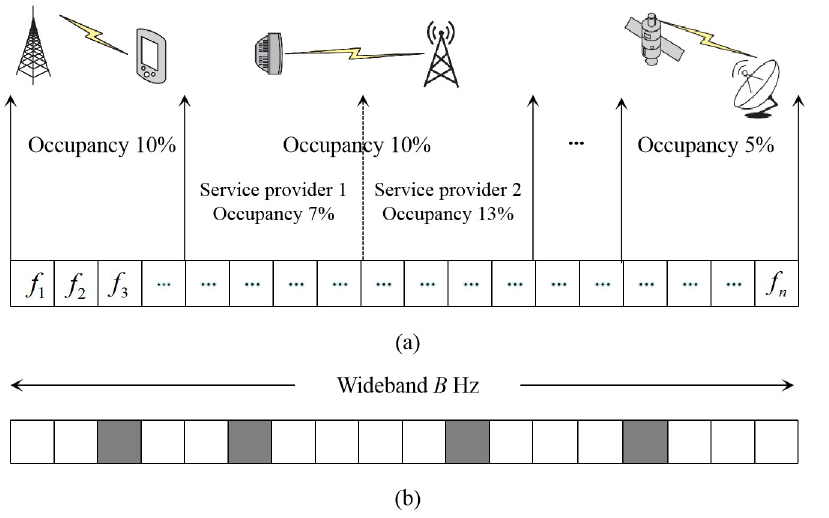
Figure 1. ( a ) Spectrum occupancy in a real scenario. ( b ) The grey areas indicate the occupied channels and the white areas indicate the idle